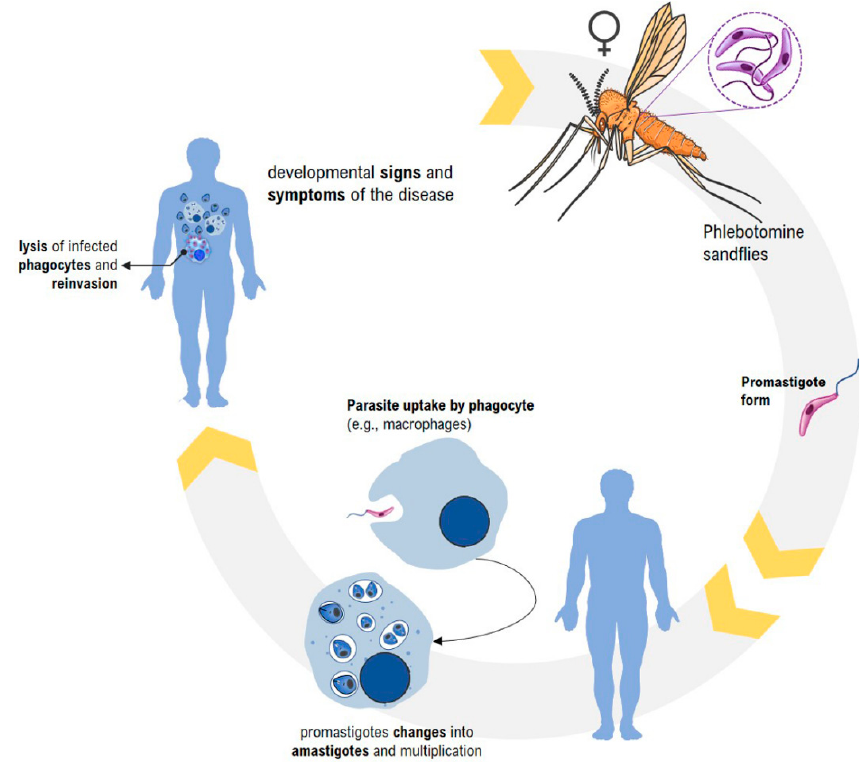
Figure 2. The stages of the Leishmania parasite in its life cycle.